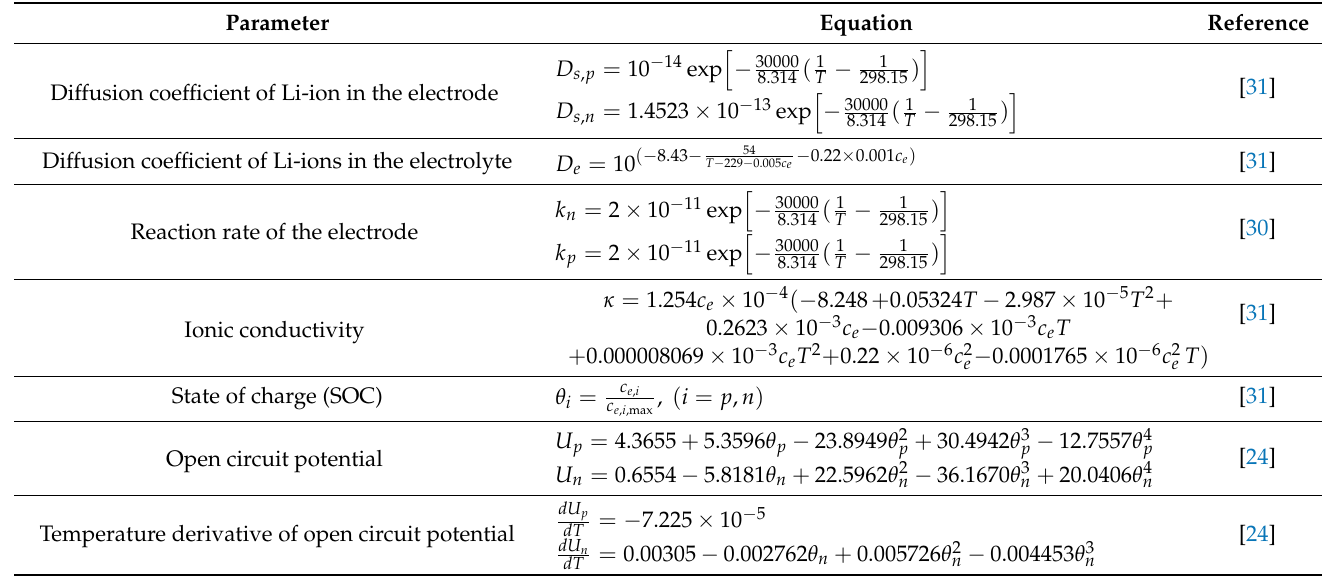
Table 4. Variables for PP2D model of the 50Ah battery